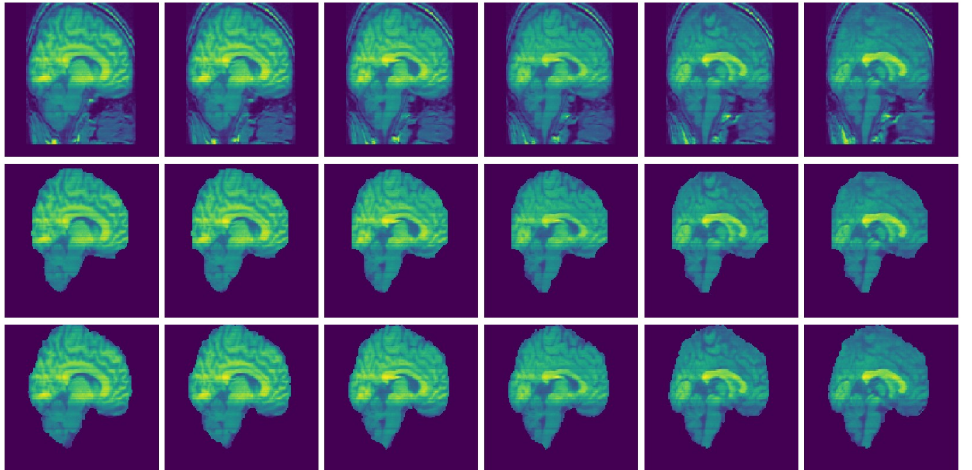
Figure 9. Selected MRI slices (IBSR data set): Sagittal MRI plane segmented brain. Row one: Input images, Row two: Predicted brain and Row three: Ground truth brain.